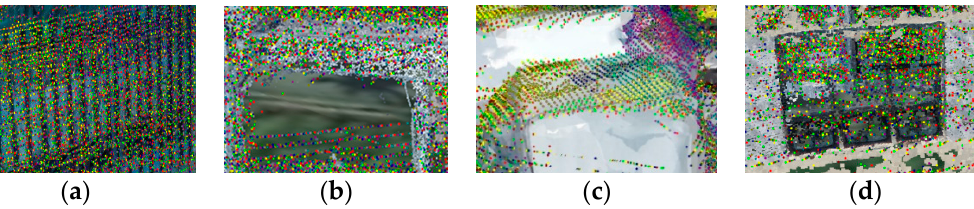
Figure 14. Four parts of the area. ( a ) Common non-shaded area, ( b ) common shaded area, ( c ) shaded area not in actual flight but in simulator, and ( d ) shaded area not in simulator but in actual flight. In the first scenario, the true-positive area, s c , is 51.36 m 2 ; the true-negative area is 2151.49 m 2 ; the false-positive area is 39.60 m 2 ; and the false-negative area is 85.68 m 2 (Table 9). Table 10 shows the index used to validate the shaded area detection. Table 9. Size of each area (m 2 ) of validation measured by the simulator and the real flight. Shaded Area in the Shaded Area in Common Object Actual Flight the Simulator Shaded Area Scenario Surface ( s s ) ( s total )